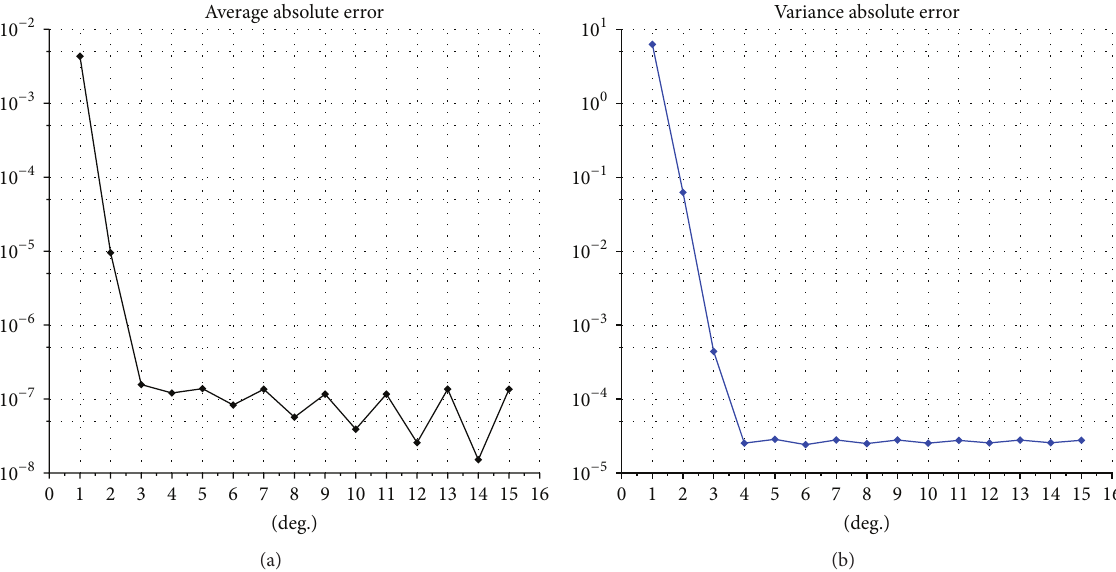
Figure 3: Semilogy scale plot of the absolute error of the mean (a) and the variance (b) computed via PCE for GBM at time 𝑇 = 1 , whose parameters are 𝑟 = 3 %, 𝜎 = 15 %, and starting value 𝑆 0 = 100 , for a set of degrees 𝑝 = {1, 2,. .. , 15} .